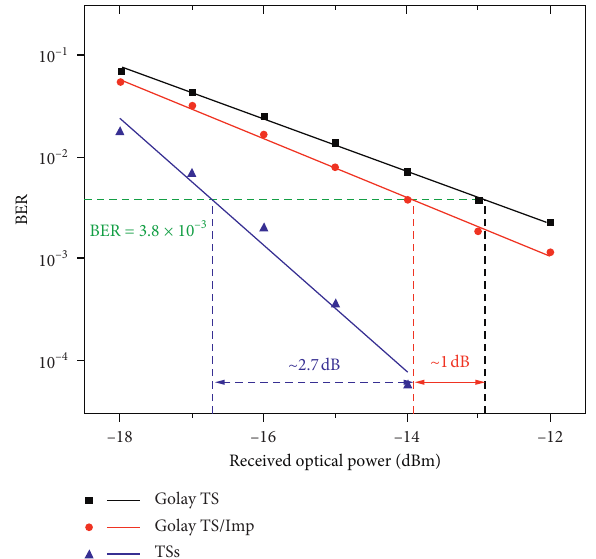
Figure 3: BER performance based on channel estimation of three training